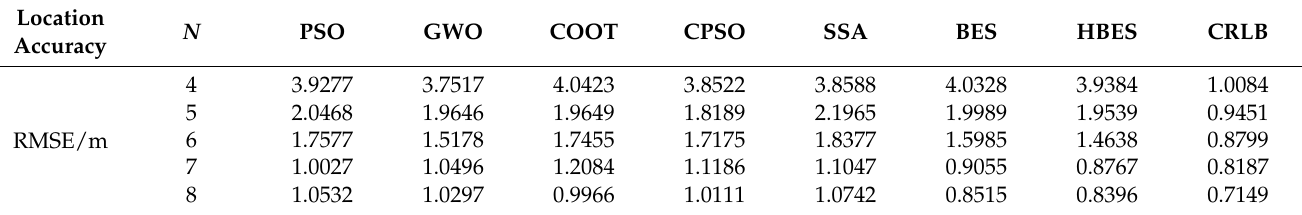
Table 5. Localization accuracy comparison of a different number of base